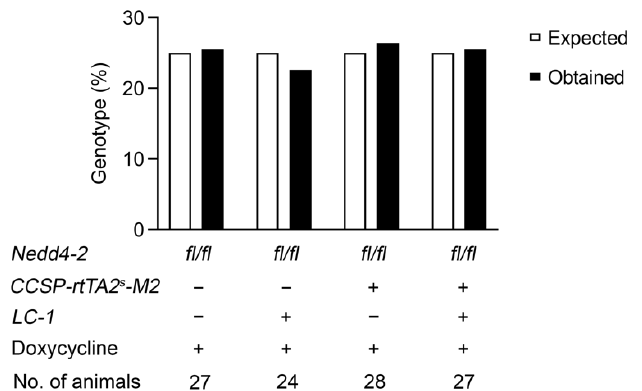
lung sections ( d ) in mice with the different genotypes that served as controls to exclude potential off-target effects of the expression system. Dams were treated with doxycycline from the start of mating and offspring was studied 3 weeks after birth. Upper row, scale bars, 1 mm. Lower row, scale bars, 50 µ m. n = 9–10 mice per group. Data are shown as mean ± S.E.M.